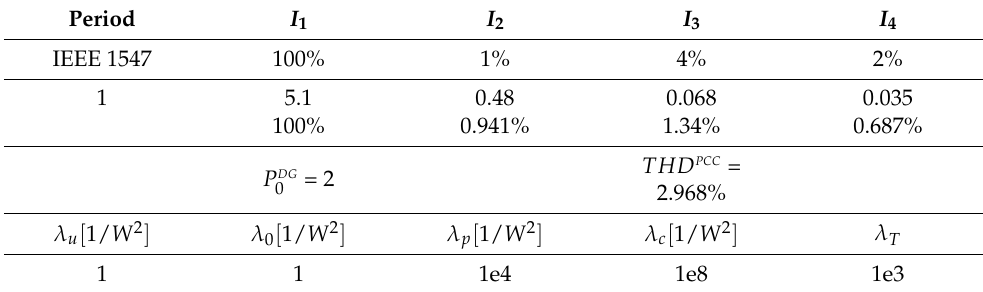
Figure 7. Power and currents delivered by the PCC for case 3: ( a ) Time domain PCC signals and ( b ) Frequency spectrum when IEEE std 1547 compliance was settled. Table 5. Measured currents and weighting